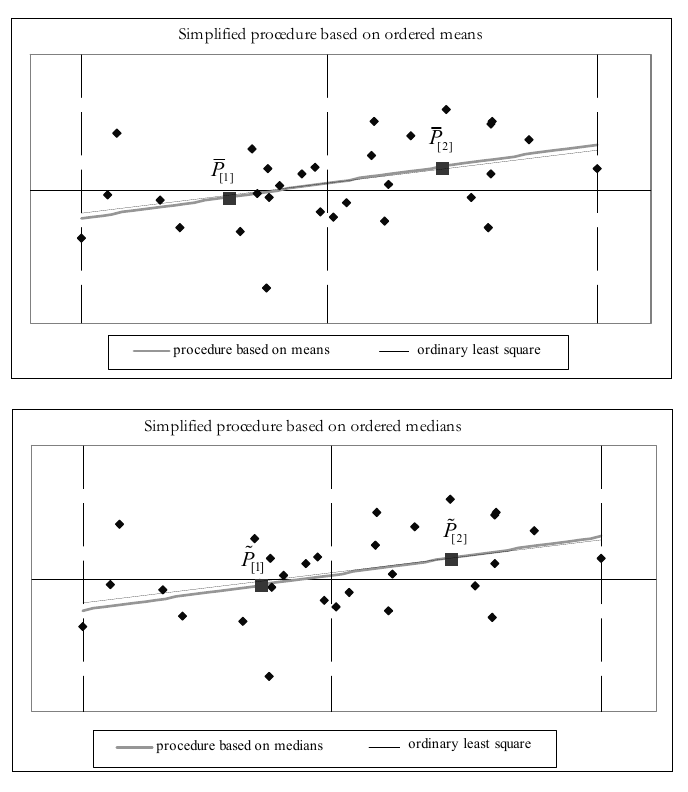
Figure 2 – The proposed simplified procedure: an example for n = 30, m = 2, r =